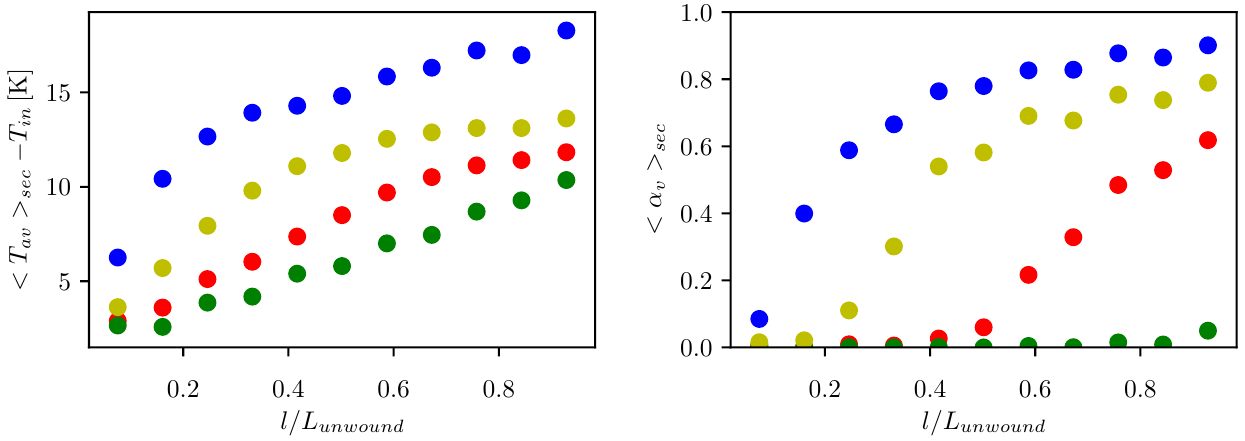
Figure 12. Averaged temperature and void fraction evolutions in the streamwise direction, for the sections defined in Figure 6, for various cases: case a in red; case c in blue; case d in green; case e in yellow. ( Left ): fluid average temperature. ( Right ): averaged void